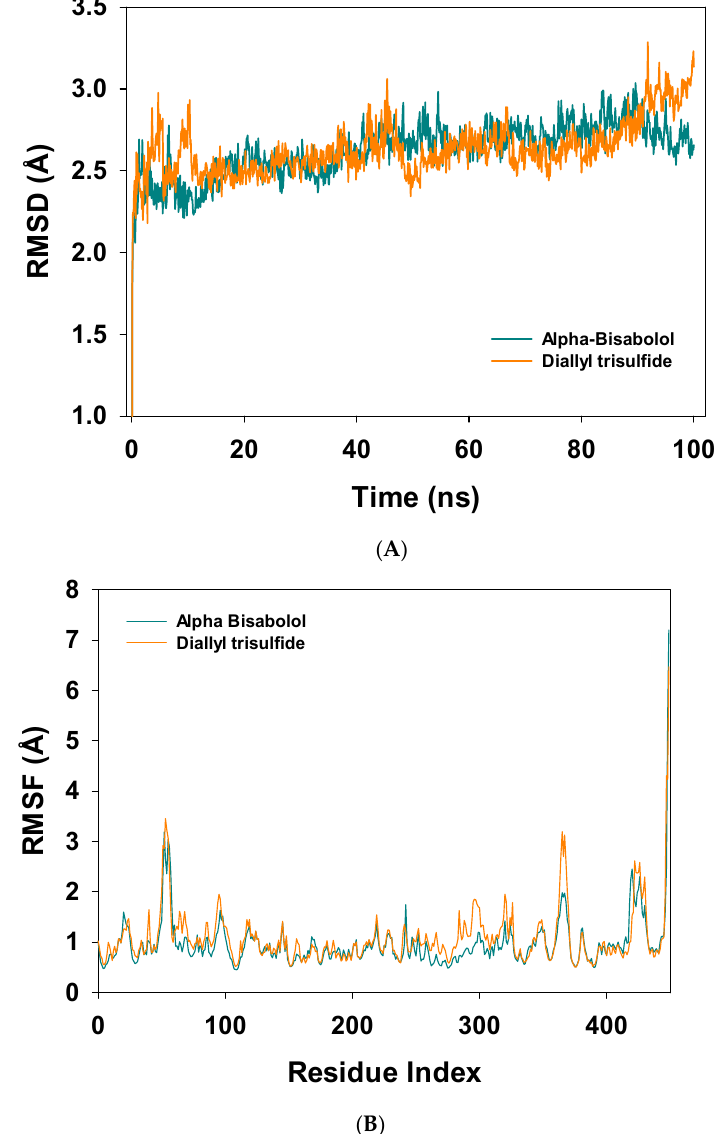
Figure 2. ( A ) RMSD plot of C α atoms of NADPH oxidase displaying deviations from the mean with α -bisabolol (dark cyan) and diallyl trisulfide (orange) over a 100 ns time scale simulation. ( B ) RMSF plot of amino acids of NADPH oxidase bound to α -bisabolol (dark cyan) and diallyl trisulfide (orange) over a 100 ns time scale simulation.